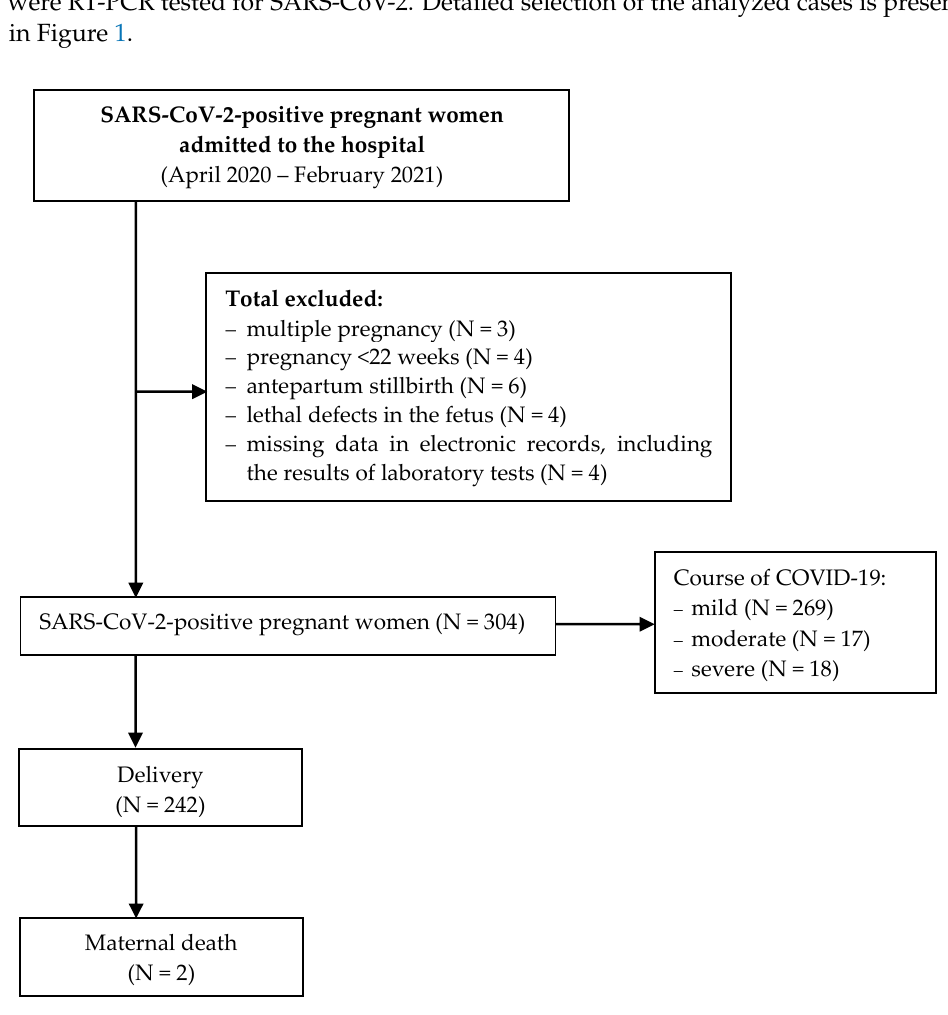
Figure 1. Flow diagram of the exclusions and final analytic samples.